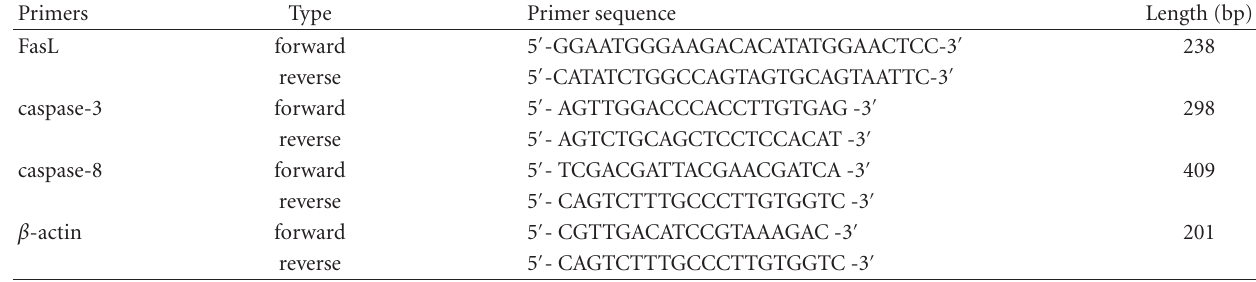
Table 1: Description of primers used in the present study.